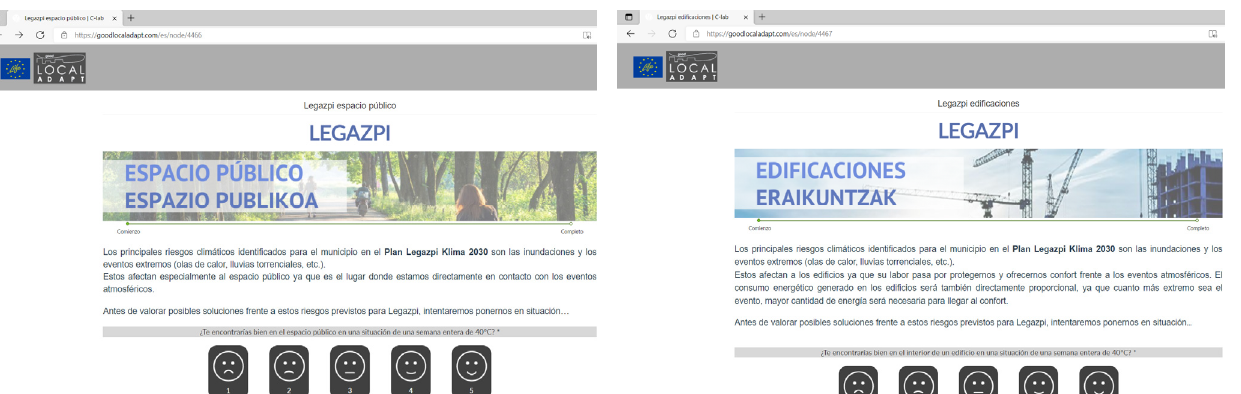
Figure 8. Consensus bars of the consultation method of Balmaseda. 4.2.3. Participation Indicators The overall participation across all three municipalities amounted to 154 people, as shown in the table below. The main participation channel was face ‐ to ‐ face, with digital